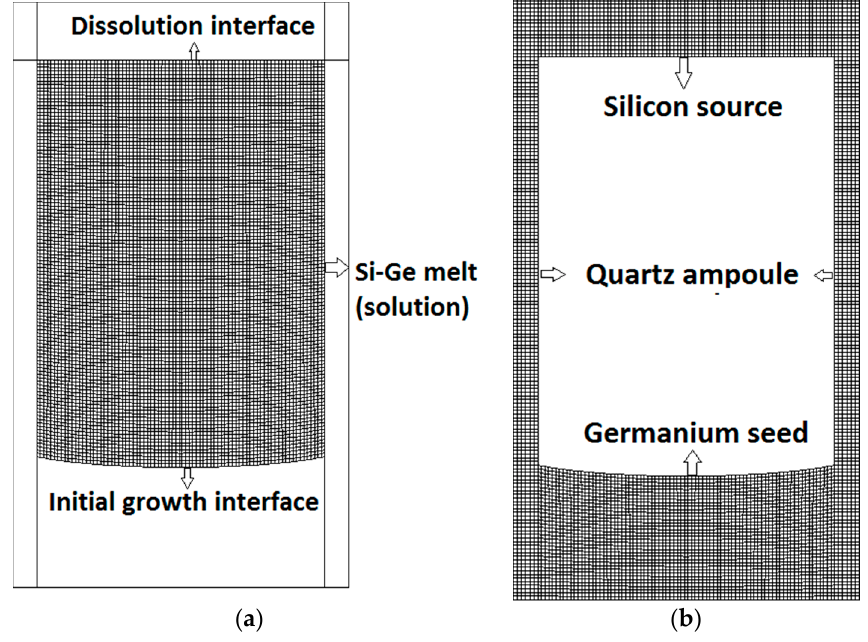
Figure 1. Initial computational mesh used for numerical simulation in the ( a ) Liquid subdomain (b ) Solid subdomains.